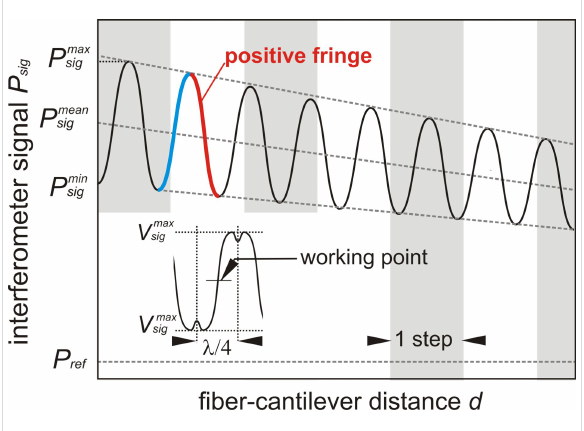
Figure 4: Schematic representation of the interferometer signal P sig as a function of the fiber–cantilever distance d . Coarse-approach piezo steps are marked as gray boxes. The inset schematically shows the oscilloscope trace of V sig for a cantilever excited to an amplitude of larger than λ